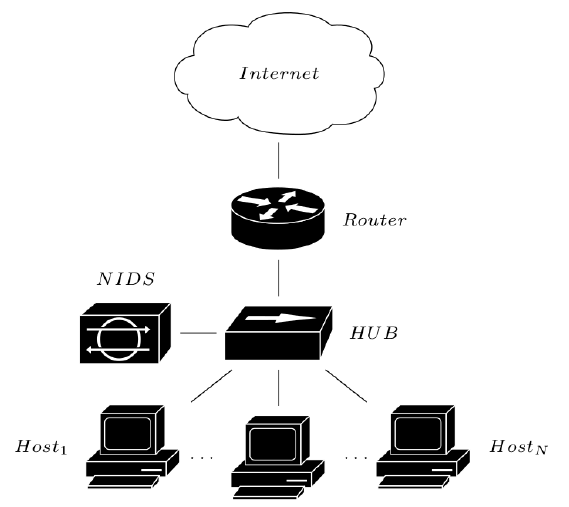
Figure 3. IDS network-based modality.